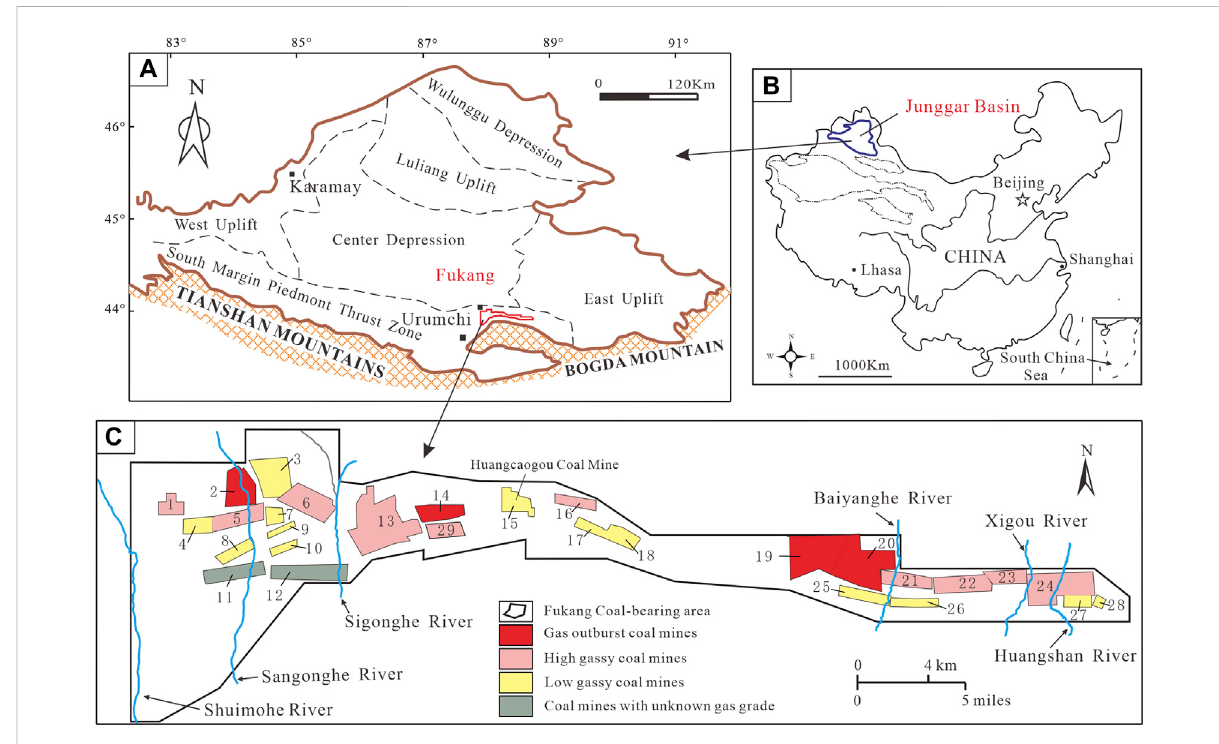
FIGURE 1 (A) -Geographical location of the Junggar Basin. China. (B) -Tectonic units of the southern Junggar Basin and location of the Fukang area. (C) - Distribution of major coal mines and its potential of coal-and-gas outburst in the Fukang area. (1-Mopangou mine, 2- Qimei No. 2 mine,